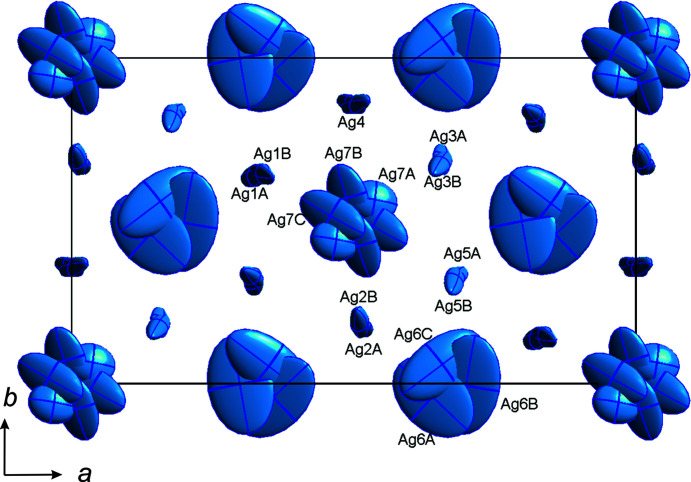
Displacement ellipsoid plot (95% probability level) for the Ag+ ions in Ag3Sc2(PO4)3 at 200 K viewed down [001].